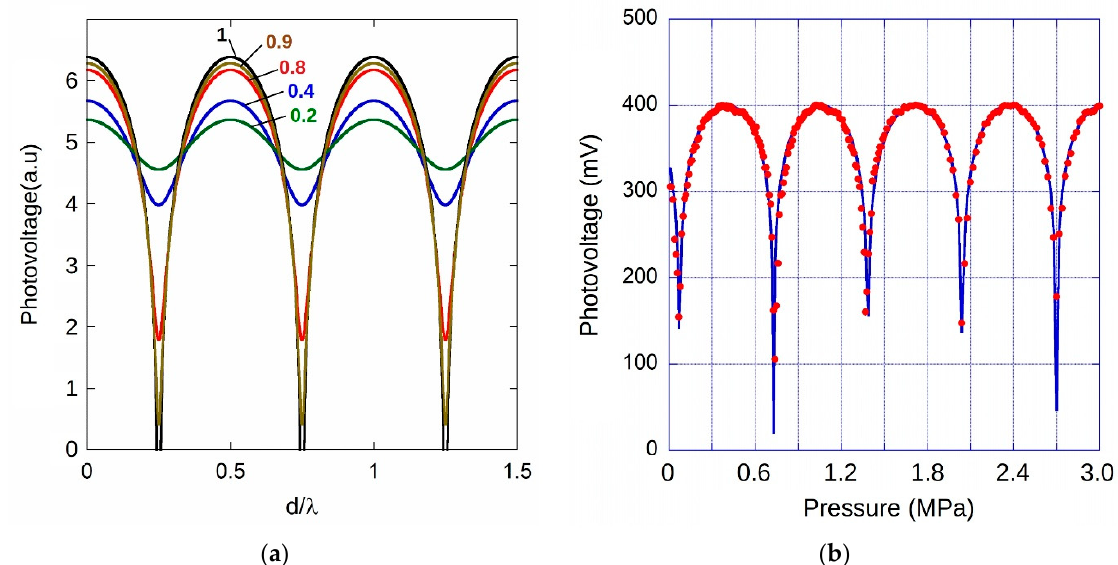
Figure 11. ( a ) Simulated photovoltage output signal behavior of PD as a function of the FP cavity length normalized to the wavelength of impinging light for different A 2 / A 1 intensity ratio of reflected beams. ( b ) Photovoltage output signal of PD as a function of the pressure difference for a 380 μ m in diameter PCD membrane.